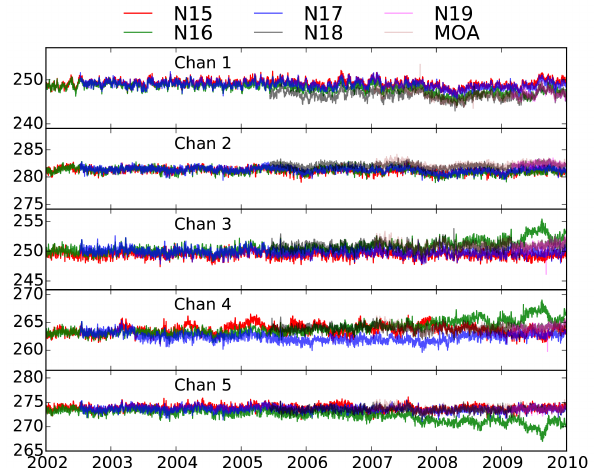
Figure 6. Analysis of the time series of observations averaged over the tropical oceans for selecting the reference satellites. NOAA-19 and MetOp-A (MOA) are intercalibrated with reference to MHS on board